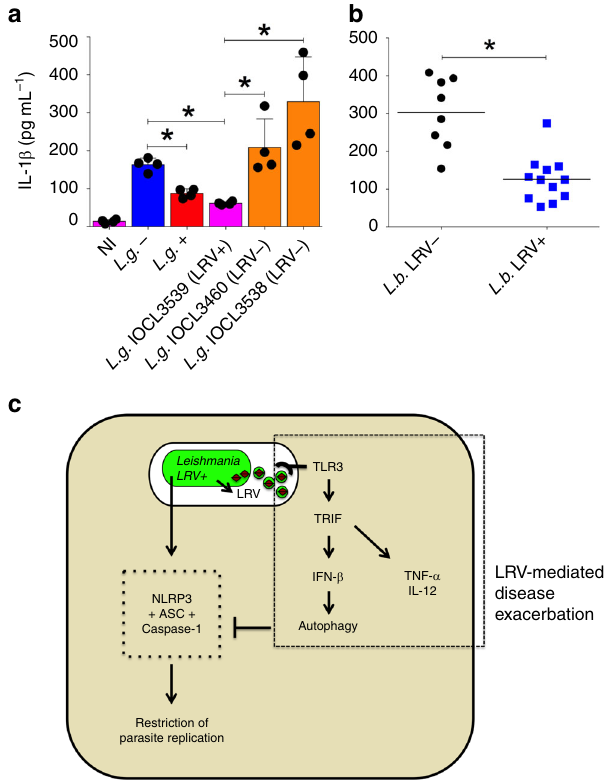
Fig. 10 LRV + clinical isolates induces less in fl ammasome activation. a LPS- primed bone marrow-derived macrophages (BMDMs) were left uninfected (NI) or infected (MOI 10) with L.g. − (blue bar), L.g . + (red bar) or different L. guyanensis clinical isolates. Two of them are LRV − (orange bars) and one is LRV + (pink bar). b LPS-primed BMDMs were infected with 20 different clinical isolates of L. braziliensis (MOI 10) obtained from different patients. Isolates that are LRV − are shown as circles (black circles) and isolates LRV + are shown in as squares (blue squares). Information of each isolate is contained in Supplementary Table 2. After 24 h of infection, cell-free supernatants were collected and the levels of IL-1 β were measured by ELISA. The average value for each clinical isolate was plotted together, according to LRV presence/absence. The results are shown as mean ± SD. Statistical analysis was performed by unpaired Student ’ s t test, with P < 0.05 (*) considered statistically signi fi cant. One representative of three independent experiments performed with technical replicates is